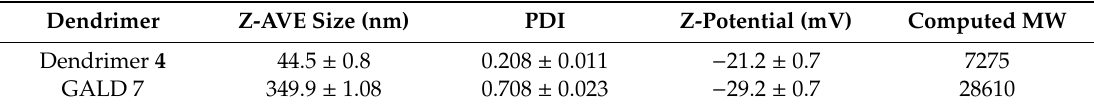
Table 2. Hydrodynamic size, PDI and Z-potential at 37 ◦ C of dendrimer 4 and GALD 7 by DLS analysis (degree of freedom N = 3) together with GALD 7 computed MW and MW of dendrimer 4 1 . Dendrimer Z-AVE Size (nm) PDI Z-Potential (mV) Dendrimer 4 1 Confirmed by 1 H NMR analysis and elemental analysis (Section